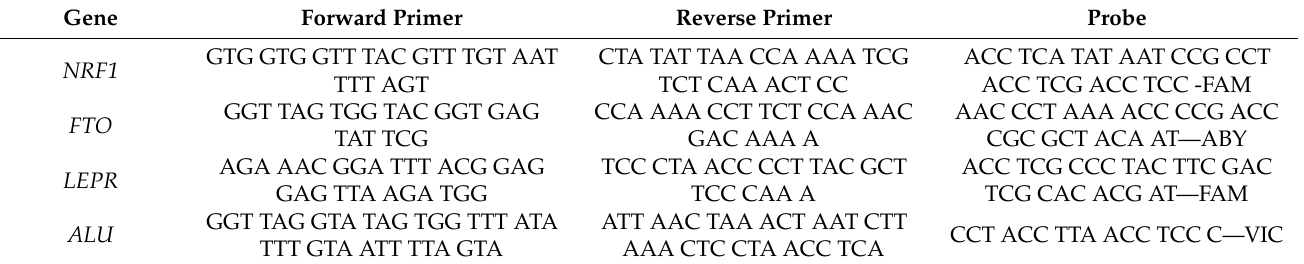
Table 1. Primer and probe sequences (5 (cid:48) to 3 (cid:48) ) for the MethyLight polymerase chain